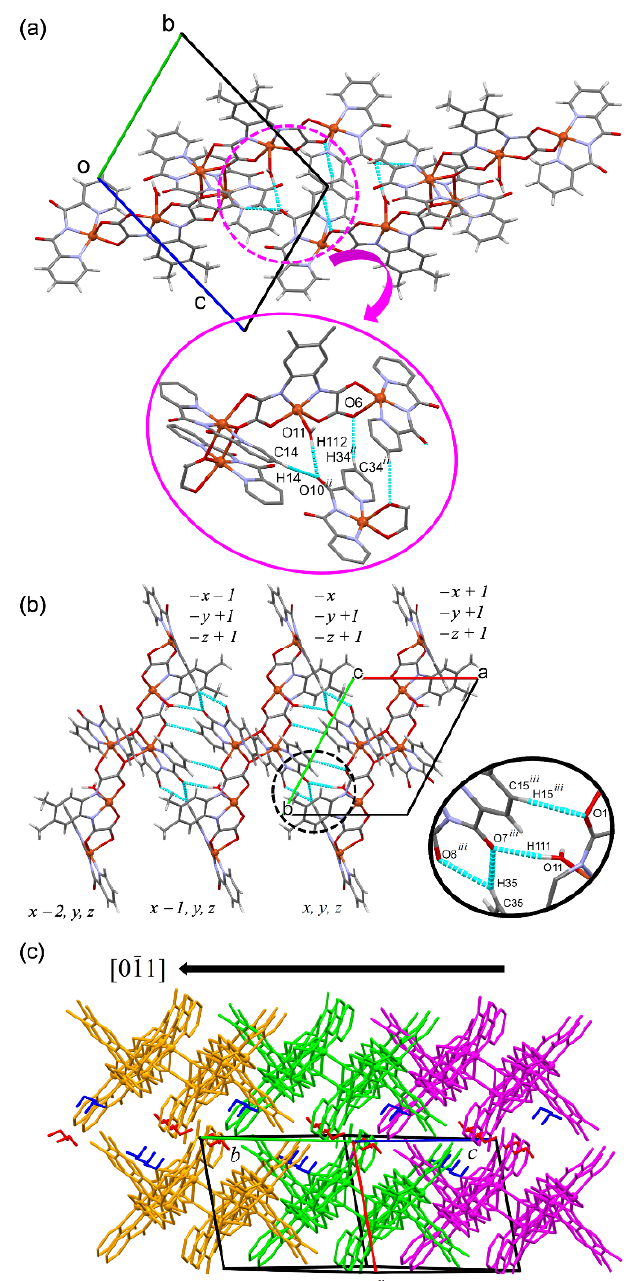
Figure 3. Partial view of the crystal packing of 1 along the crystallographic [011] ( a ) and [100] directions ( b ) showing the supramolecular connections of the hexanuclear units via hydrogen bonds (dashed cyan lines). The resulting 3D supramolecular coordination network ( c ) highlights the layered structure staked along the [011] direction (each color is a layer). Symmetry codes: (ii) − x + 1, − y + 2, − z + 2; (iii) − x, − y + 1, − z + 1. Hydrogen atoms were omitted in some views for clarity.